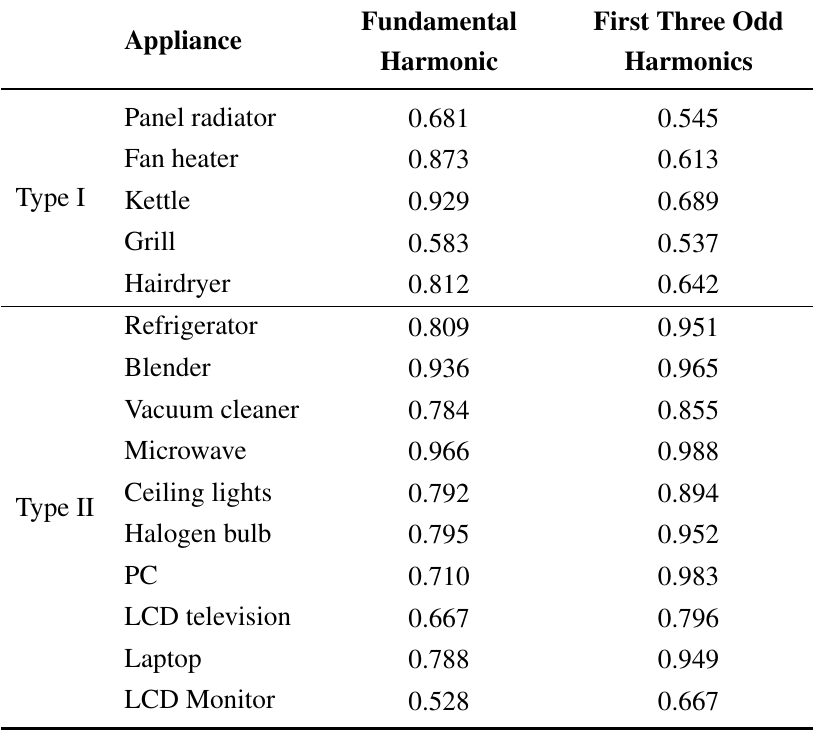
Table 9. AUC for identifying an appliance when using two different feature sets.